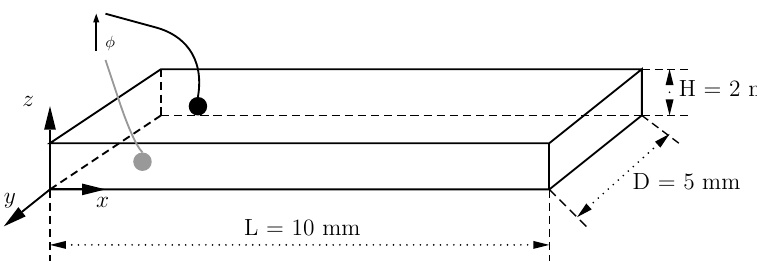
Figure 2. Single-layer beam. The poling direction of the beam is the z -axis. The length L, height H, and width D of the beam are 10 mm, 2 mm, and 5 mm,